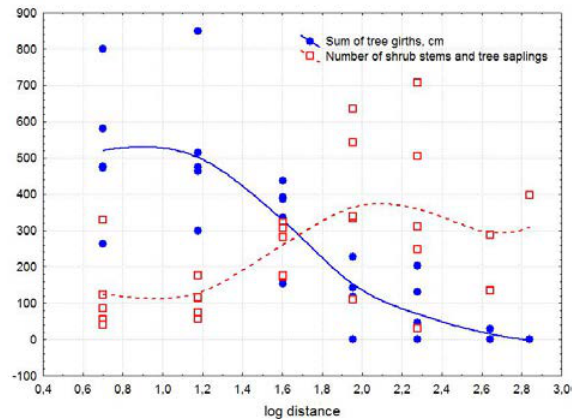
Figure 10. Relationships between the sum of tree girths and number of shrub stems and tree saplings, and log-distance from the cutoff ditch.